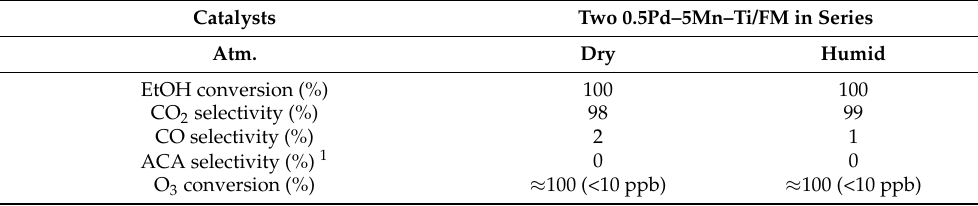
Table 6. Ethanol oxidation on two 0.5Pd–5Mn–Ti/F M full monolithic catalysts in series ( 54 channels ) in dry and humid air (10% RH) conditions (total flow rate = 500 mL · min − 1 , [EtOH] = 10 ppm, [O 3 ] = 70 ppm, T = 60 ◦ C, Time = 3